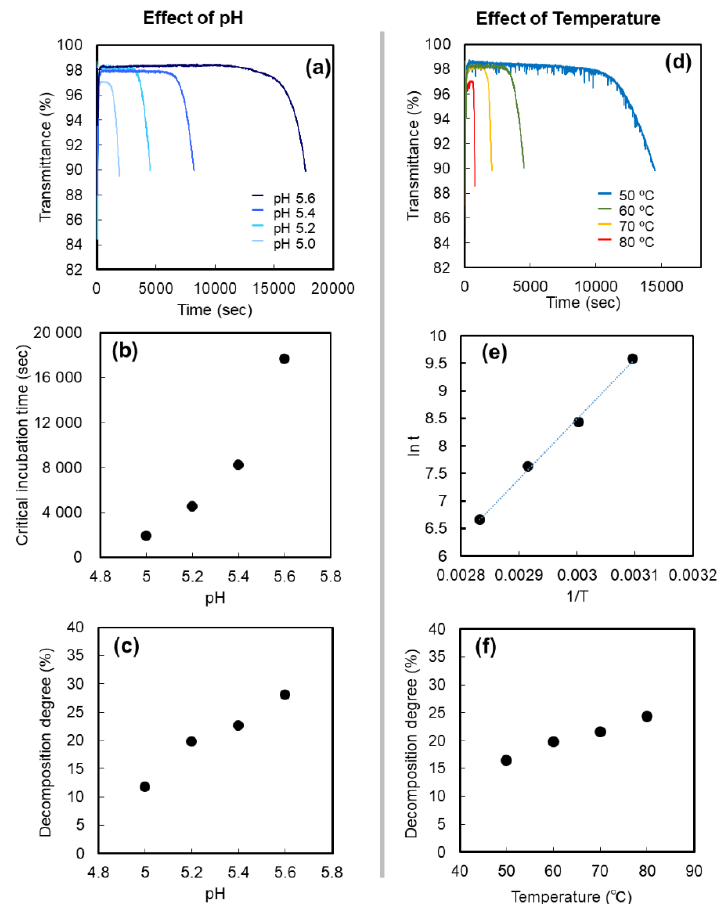
Figure 2. Time course of transmittance of aqueous solutions of PAA-Pht at different pHs ( a ) and temperatures ( d ). Critical incubation time reached 90%T of PAA-Pht aqueous solution at different pHs ( b ). Cleavage degree of amide bond in PAA-Pht at 90%T at various pHs ( c ) and temperatures ( f ). Arrhenius plot of this cleavage reaction of PAA-Pht aqueous solution ( e ). In ( a – c ), polymer concentration: 4.0 mg/mL, temperature: 60 °C. In ( d – f ), polymer concentration: 4.0 mg/mL, pH: 5.2.